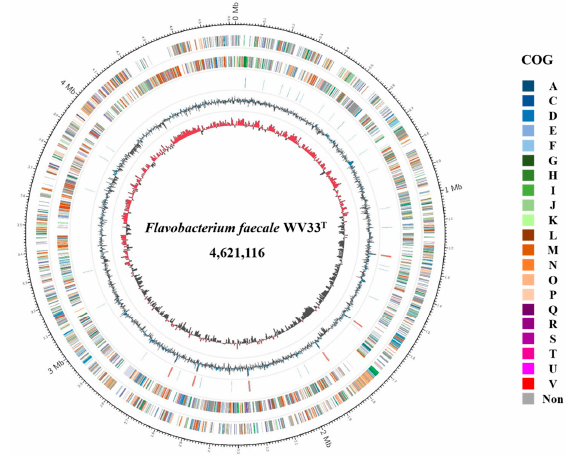
Figure 1. Circular representation of the genome of F. faecale WV33 T . From the outer to inner circle: predicted protein-coding sequences (colored by COG categories) on the plus strand, predicted protein-coding sequences (colored by COG categories) on the minus strand, RNA genes (tRNAs, blue; rRNAs, red), GC content (blue/black), and GC skew (red/black). NC in color codes of COG represents no classified category.